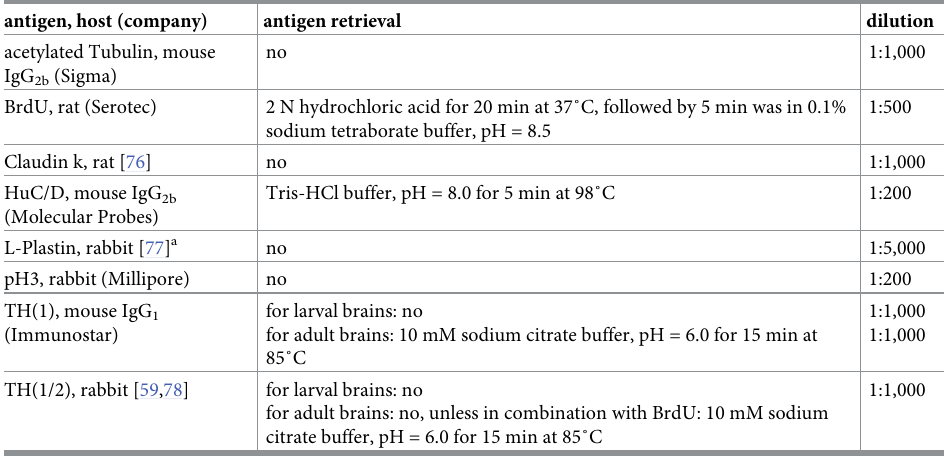
Table 7. Primary antibodies used. antigen, host